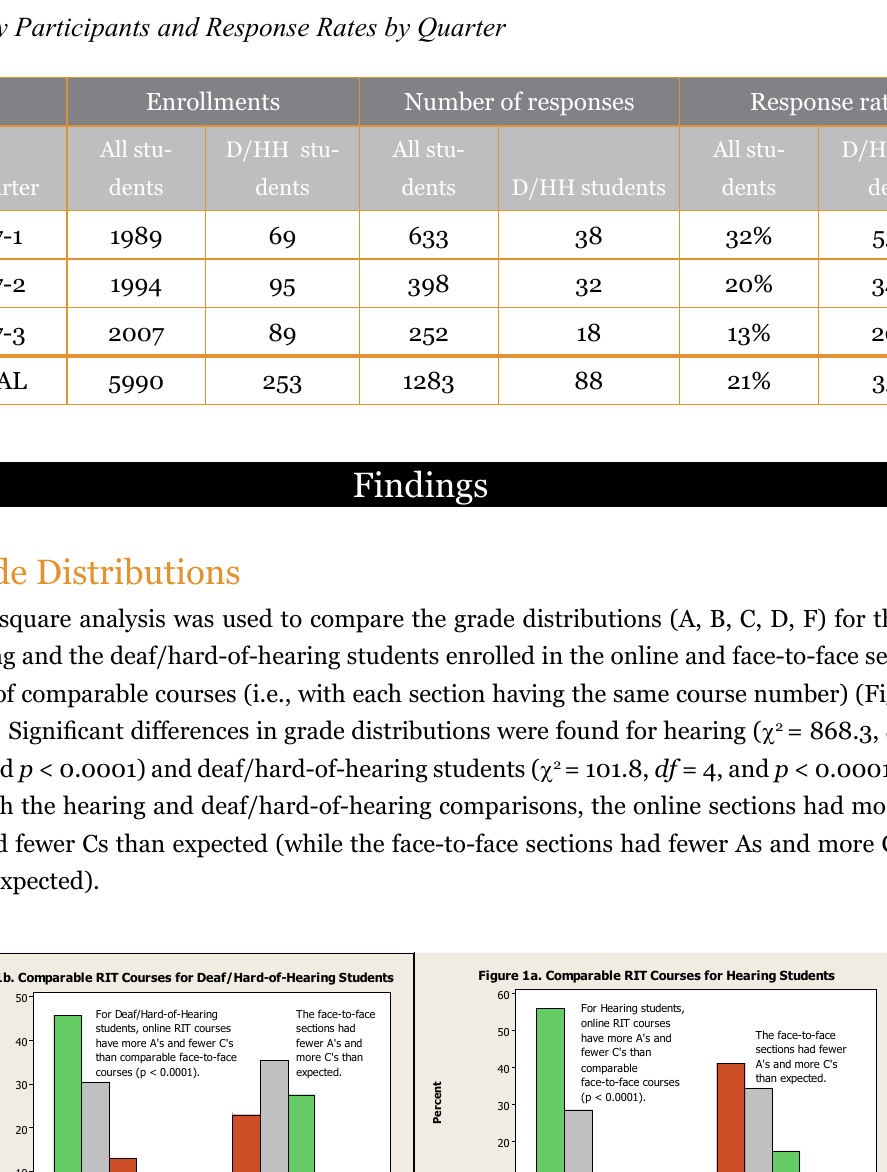
Figure 1. Grade distributions in comparable online and face-to-face